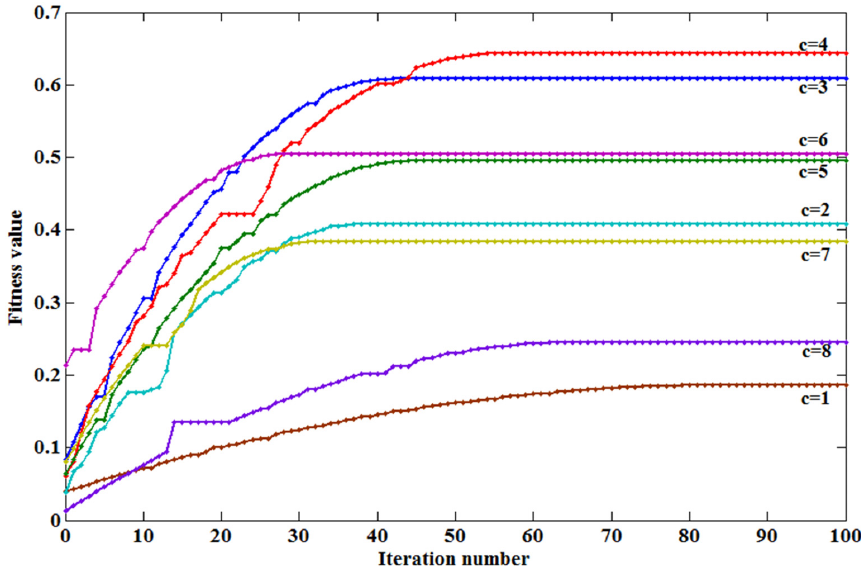
Figure 8. Iteration process at different category numbers.